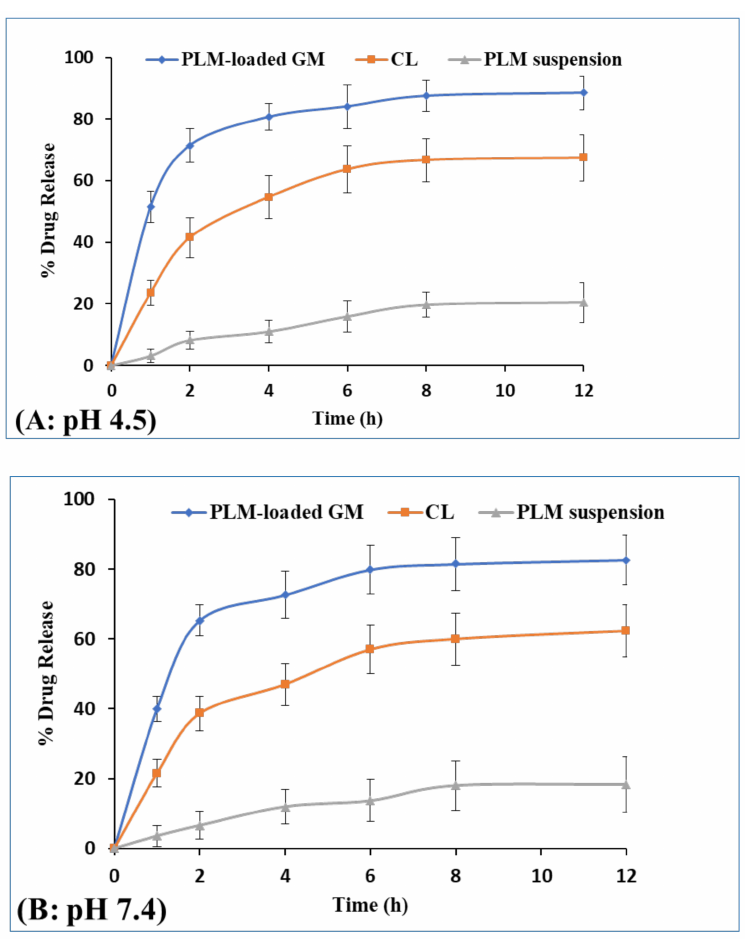
Figure 4. Percent drug release of PLM from PLM-loaded glycerosomes, CLs and PLM suspension in PBS of pH 4.5 ( A ) and 7.4 ( B ),